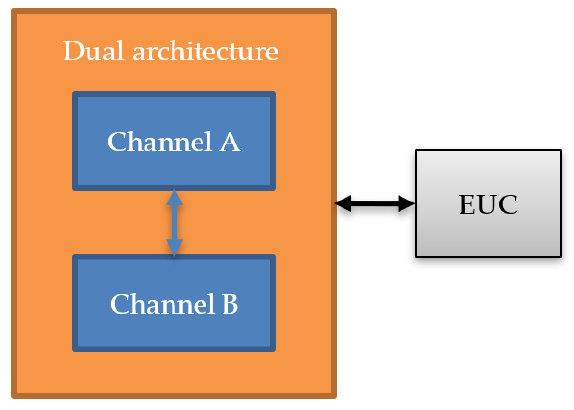
Figure 1. The principle of dual architecture.